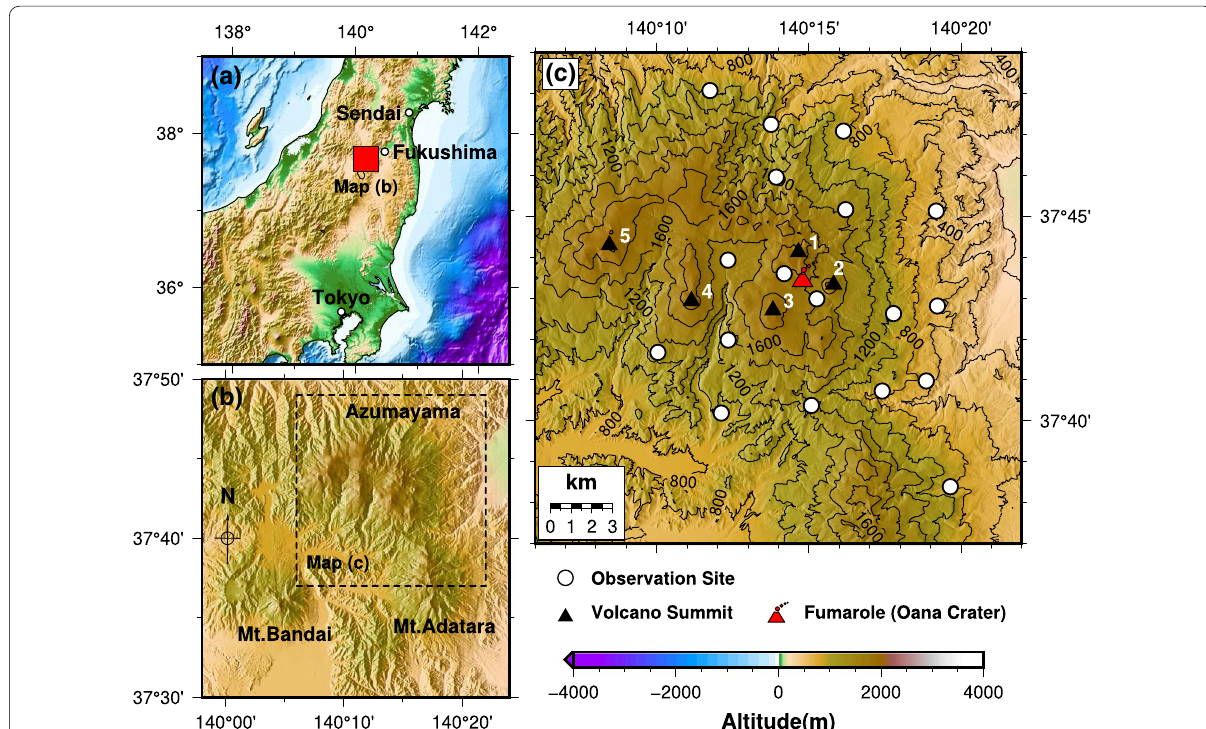
Fig. 1 Study area and the MT and GDS observation sites. a Location of study area. b Regional map of study area and adjacent locations. c Local view of the study area with the 18 MT and GDS observation sites represented by the white circles. The red triangle shows the location of the active fumarole in Oana Crater (altitude of 1720 m above sea level). The black triangles designate Azumayama Volcano edifices: 1. Mt. Issaikyo (alt. 1949 m asl), 2. Azuma-kofuji (alt. 1707 m asl), 3. Higashi-azuma (alt. 1975 m asl), 4. Naka-azuma (alt. 1931 m asl), 5. Nishi-azuma (alt. 2035 m asl). The